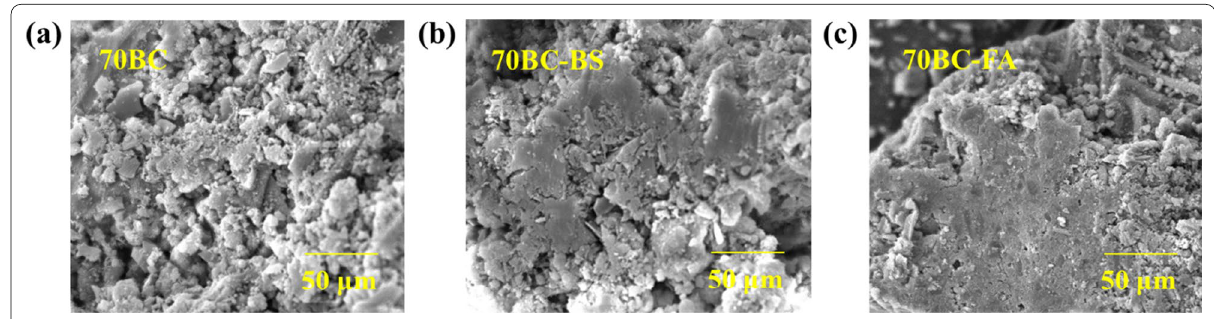
Fig. 2 SEM images of the MOSC biochar